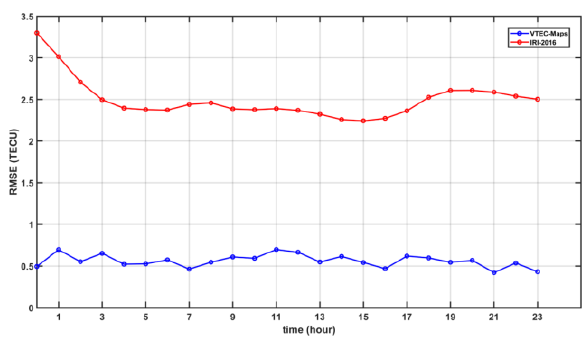
Figure 6 . The time series of RMSE values.